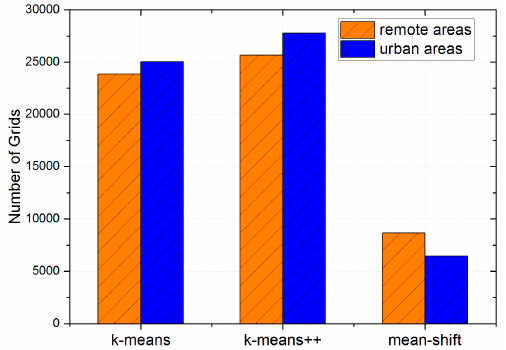
Figure 11. The number of remote and urban areas covered by uploaded data packets.